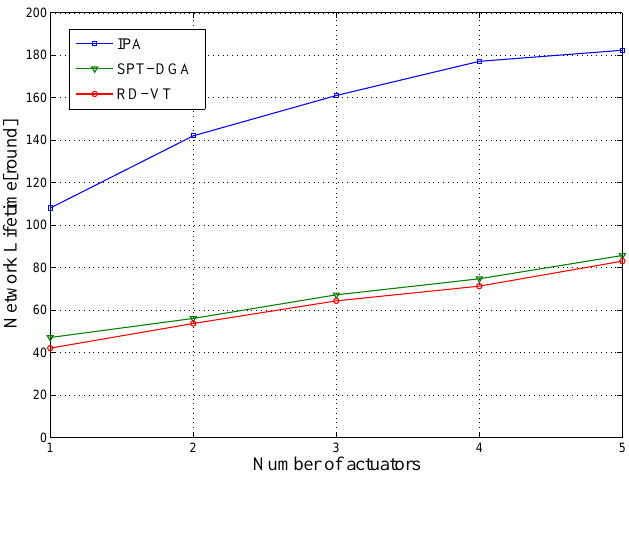
Figure 8. Energy consumption versus number of